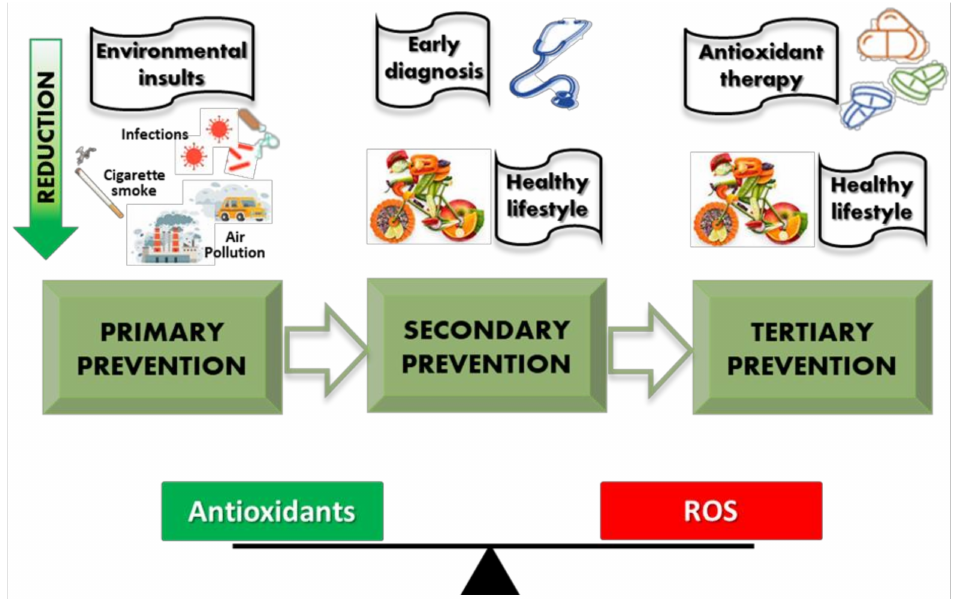
Figure 3. Primary, secondary, and tertiary preventive interventions to reduce oxidative stress. Table 2. Areas of research needs in children with